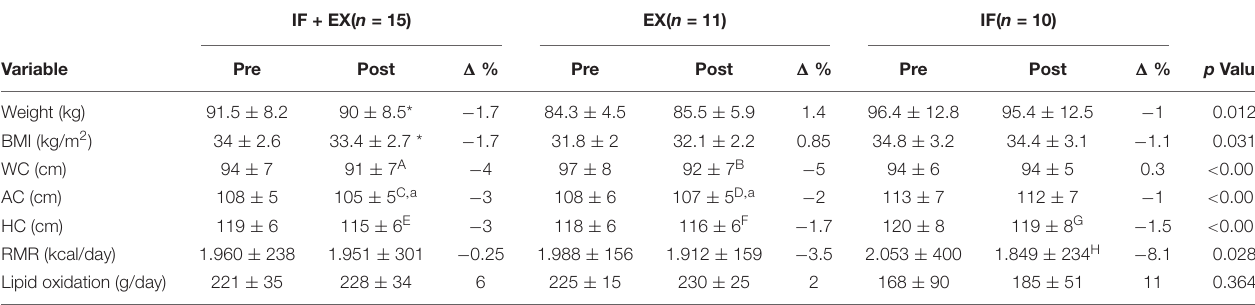
TABLE 3 | Anthropometric measures, resting metabolic rate and lipid oxidation pre and post